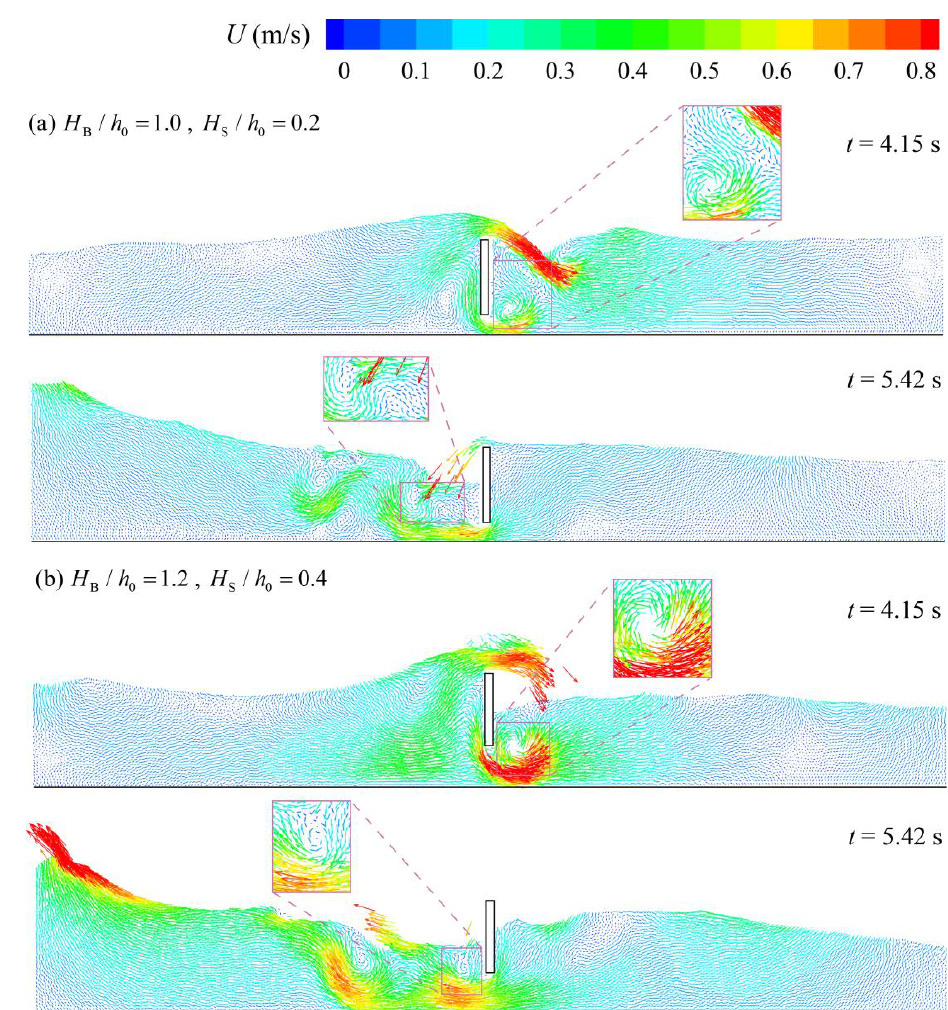
Figure 13. Distributions of velocity fields when the bottom of the baffle is suspended ( T = 1.91 s, ω / ω 0 = 1.004). ( a ) H B / h 0 = 1.0, H S / h 0 = 0.2; ( b ) H B / h 0 = 1.2, H S / h 0 = 0.4. Table 2. The comparison of impact pressure for baffles with same height but different configuration ( T = 1.91 s, ω / ω 0 = 1.004).